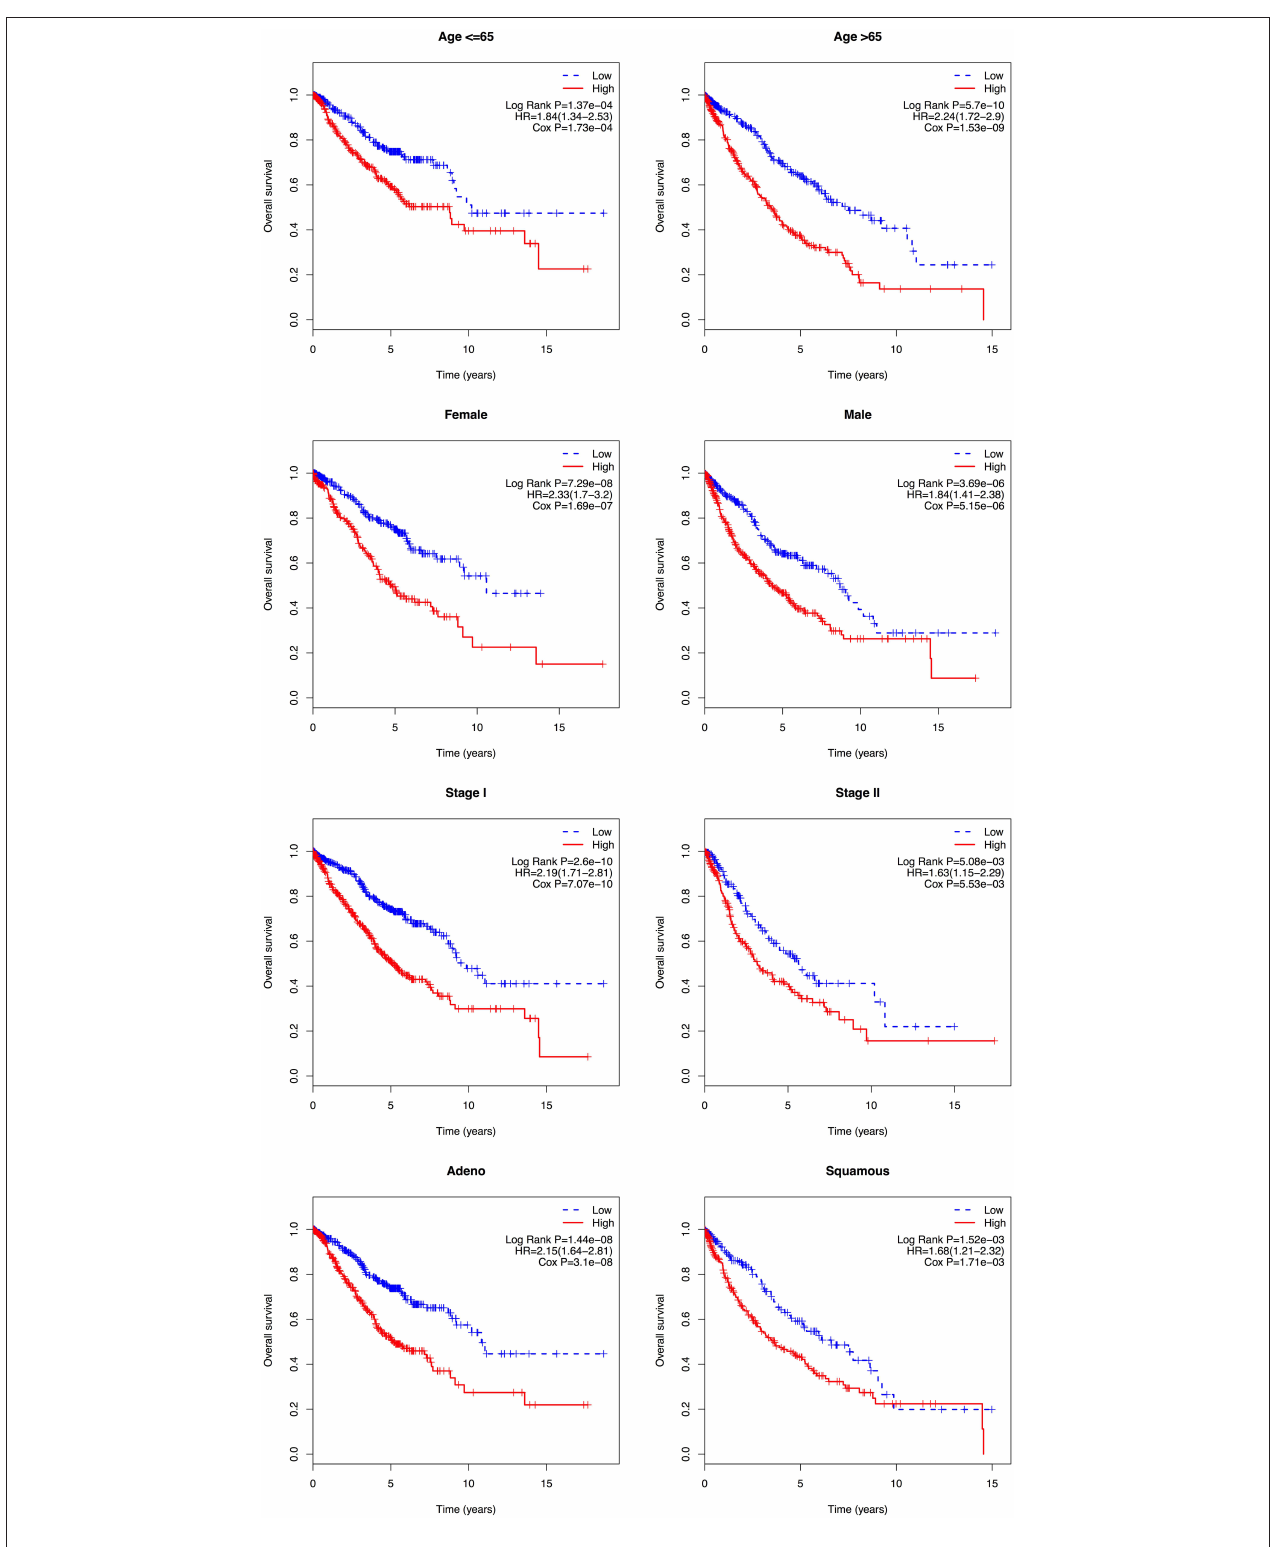
FIGURE 5 | Kaplan-Meier analysis of overall survival for patients stratified by age, gender, stage, and histological type.